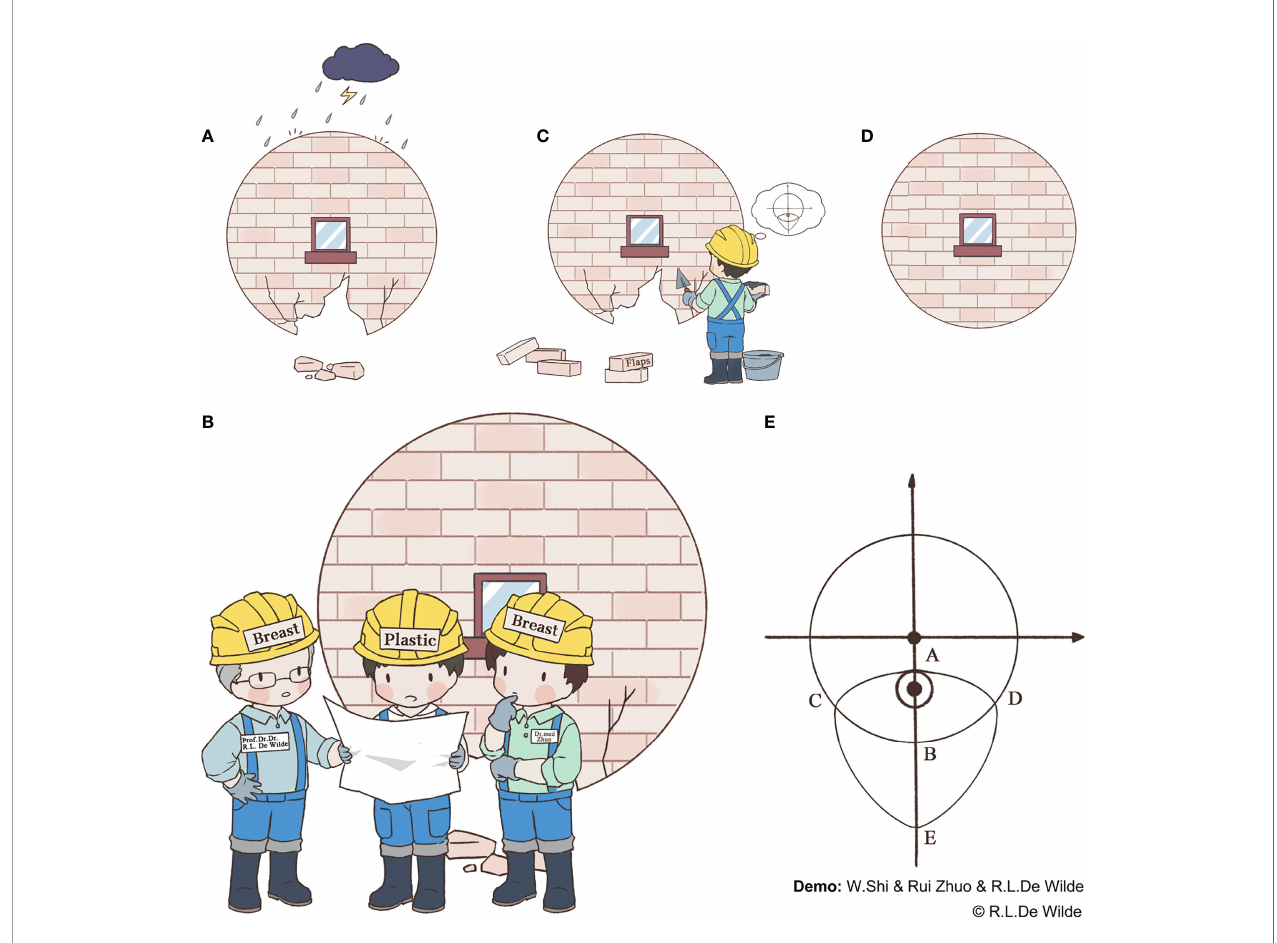
FIGURE 1 | Work fl ow and approach design for the folding fl ap